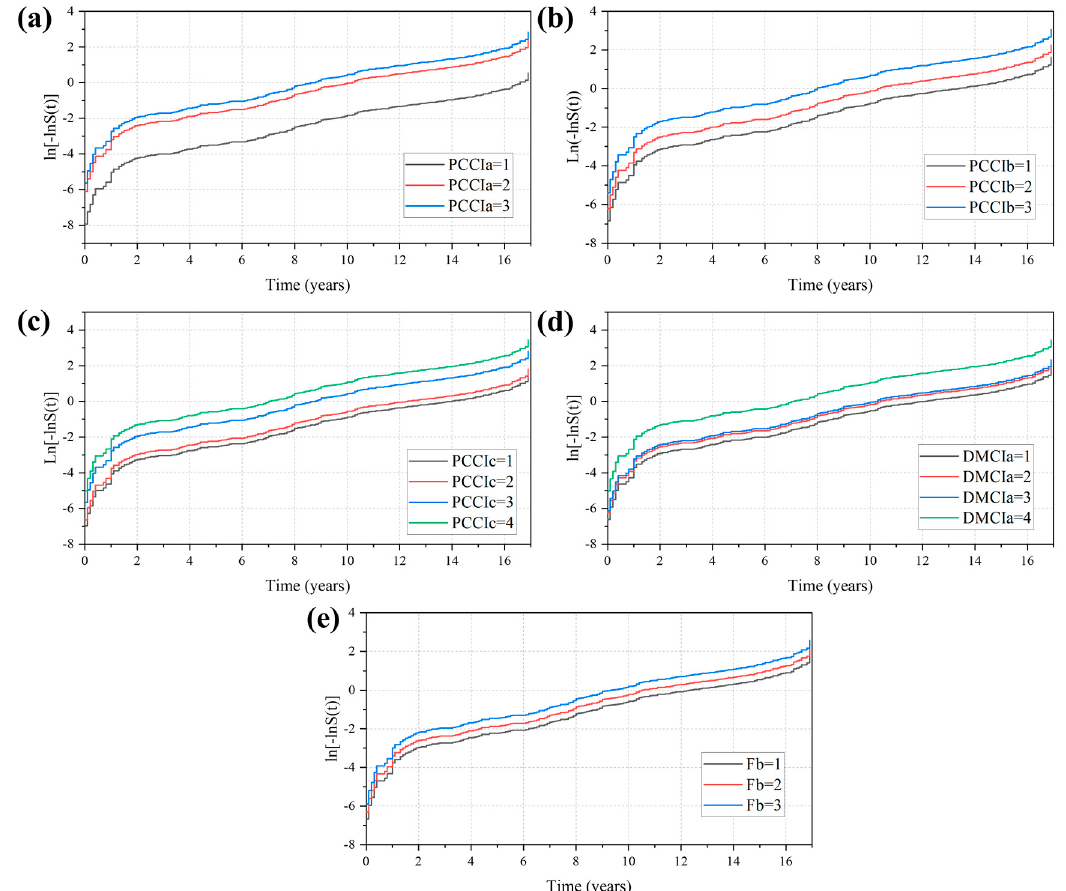
Figure 9. PH Assumption verification: ( a ) Ln[ − LnS(t)] ‐ T curve of PCCIa ; ( b ) Ln[ − LnS(t) ‐ T curve of PCCIb ; ( c ) Ln[ − LnS(t)] ‐ T curve of PCCIc ; ( d ) Ln[ − LnS(t)] ‐ T curve of DMCIa ; ( e ) Ln[ − LnS(t)] ‐ T curve of Fb.